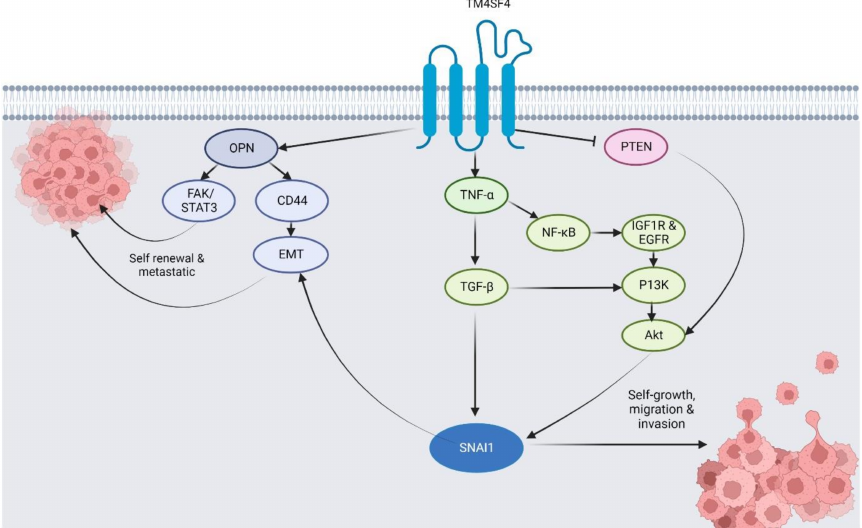
Figure 3. The proposed mechanism underlying the roles of TM4SF4 toward cancer phenotypes and